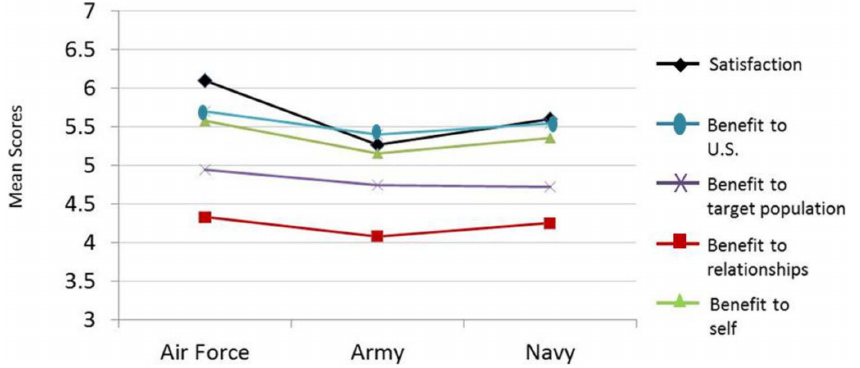
Figure 1. Group comparisons by service. Plots of mean scores for participants’ self-reported satisfaction, benefit to U.S., benefit to target population, benefit to relationships, and benefit to self (organized by service). Statistically significant differences were found between the services for satisfaction, benefit to relationships, and benefit to self. All survey variables were measured using a 7-point, Likert-type response scale. doi:10.1371/journal.pone.0057814.g001 PLOS ONE |